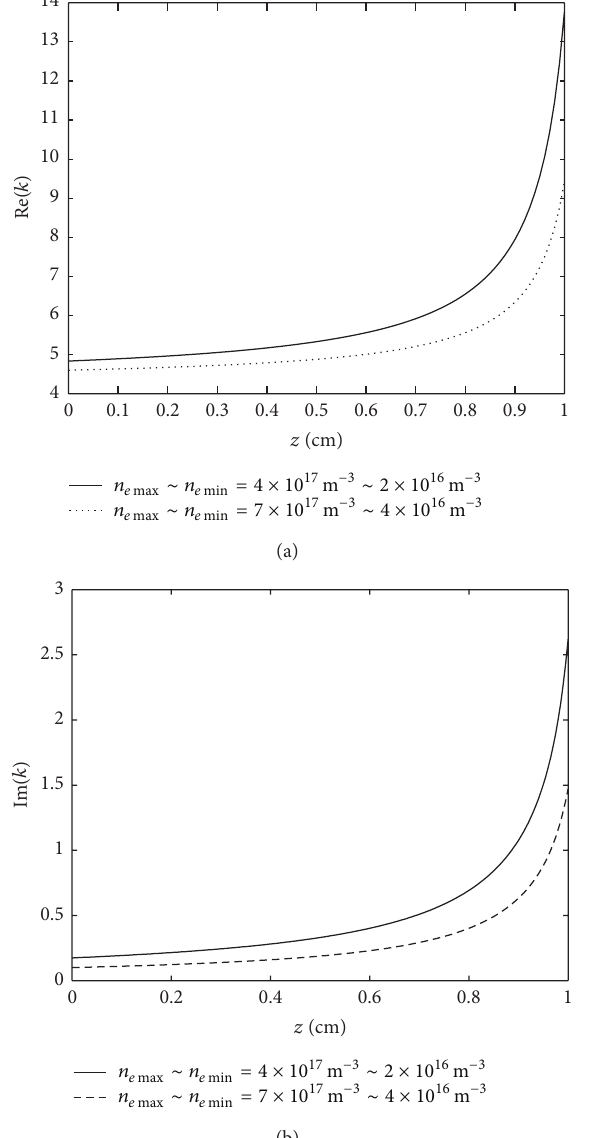
Figure 2: Real part and imaginary part of the wave vector 𝑘 along the plasma antenna.